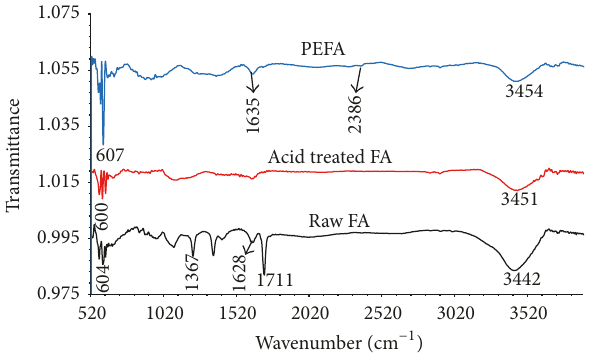
Figure 6: IR spectra of RFA, AFA, and PEFA.